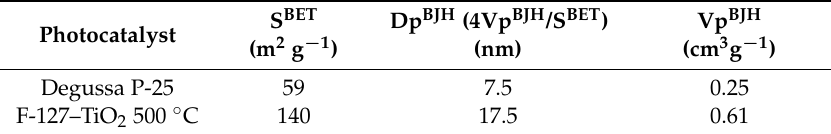
Table 1. Surface area and pore diameter using template Pluronic